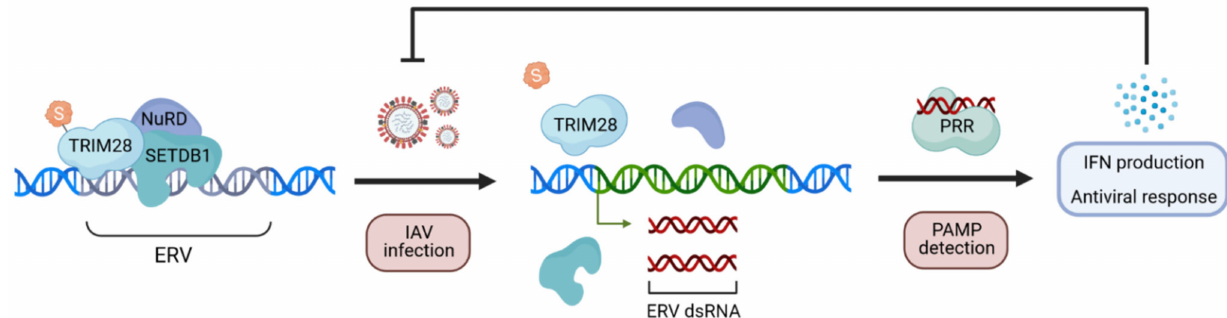
Figure 6. Example of how SUMO proteomics has identified a new type of innate antiviral response. Model of the infection- triggered TRIM28 SUMO-switch identified by proteomics that leads to increased antiviral responses. Influenza A virus (IAV) infection causes loss of SUMOylated TRIM28, destabilizing a multi-protein transcriptional repression complex and permitting endogenous retroelement (e.g., endogenous retrovirus, ERV) release. ERV expression can lead to the formation of endogenous ‘self’ double-stranded (ds) RNA that may be sensed by cellular Pattern Recognition Receptors (PRRs) that normally detect exogenous Pathogen-Associated Molecular Patterns (PAMPs), such as viral dsRNA, and trigger antiviral immunity via IFN